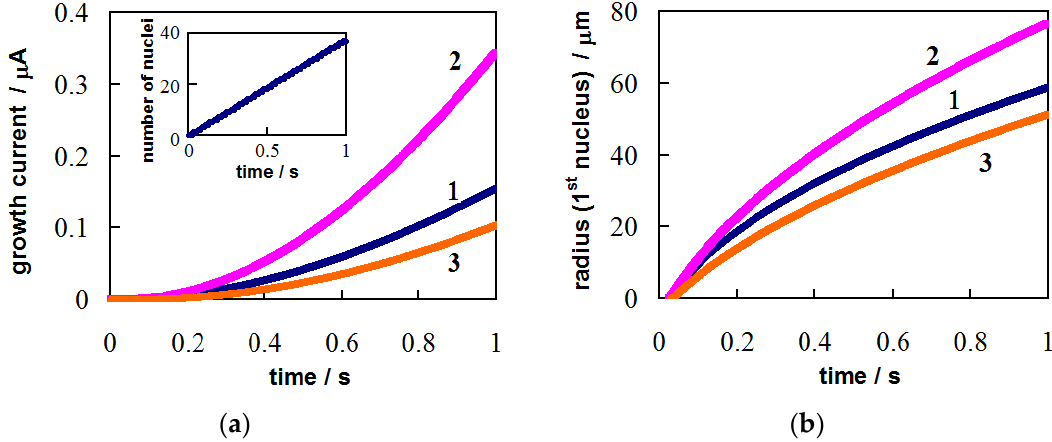
Figure 1. Calculated time dependences of ( a ) the total growth current and ( b ) the first nucleus radius under potentiostatic conditions ( η = 40 mV). Inset: the time dependence of the number of nuclei. The values of bulk concentration of depositing ions ( c 0 ) and the exchange current density at the nucleus/electrolyte interface ( i 0 ): c 0 = 1 × 10 19 cm − 3 , i 0 = 1 A cm − 2 (curve 1, blue); c 0 = 2 × 10 19 cm − 3 , i 0 = 1 A cm − 2 (curve 2, pink); c 0 = 1 × 10 19 cm − 3 , i 0 = 0.6 A cm − 2 (curve 3, orange). Other parameters are provided in the text.